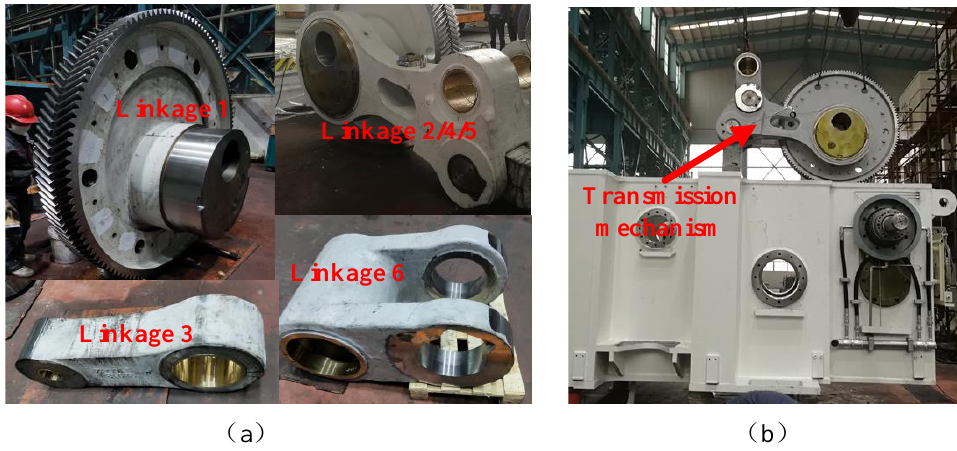
Figure 8. Transmission mechanism components and assembly process. (a) Different linkage components (b) Assembly process